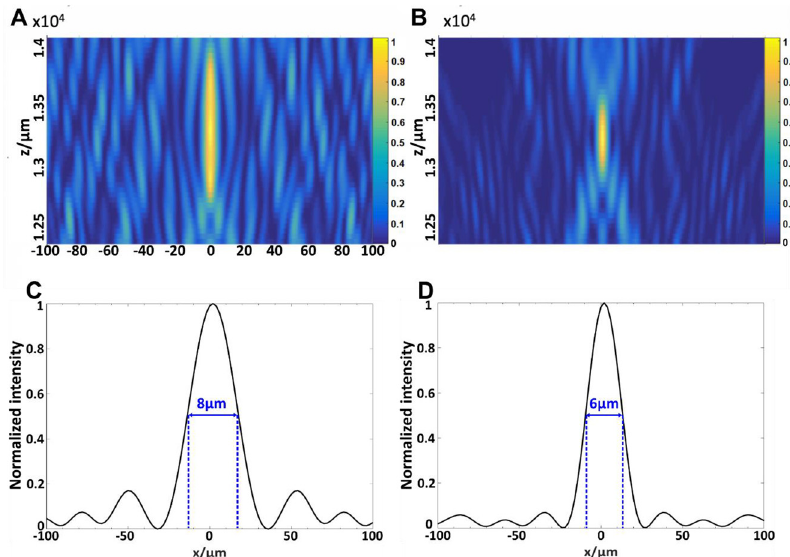
Figure 3: Comparison of different coefficient combinations on the generated